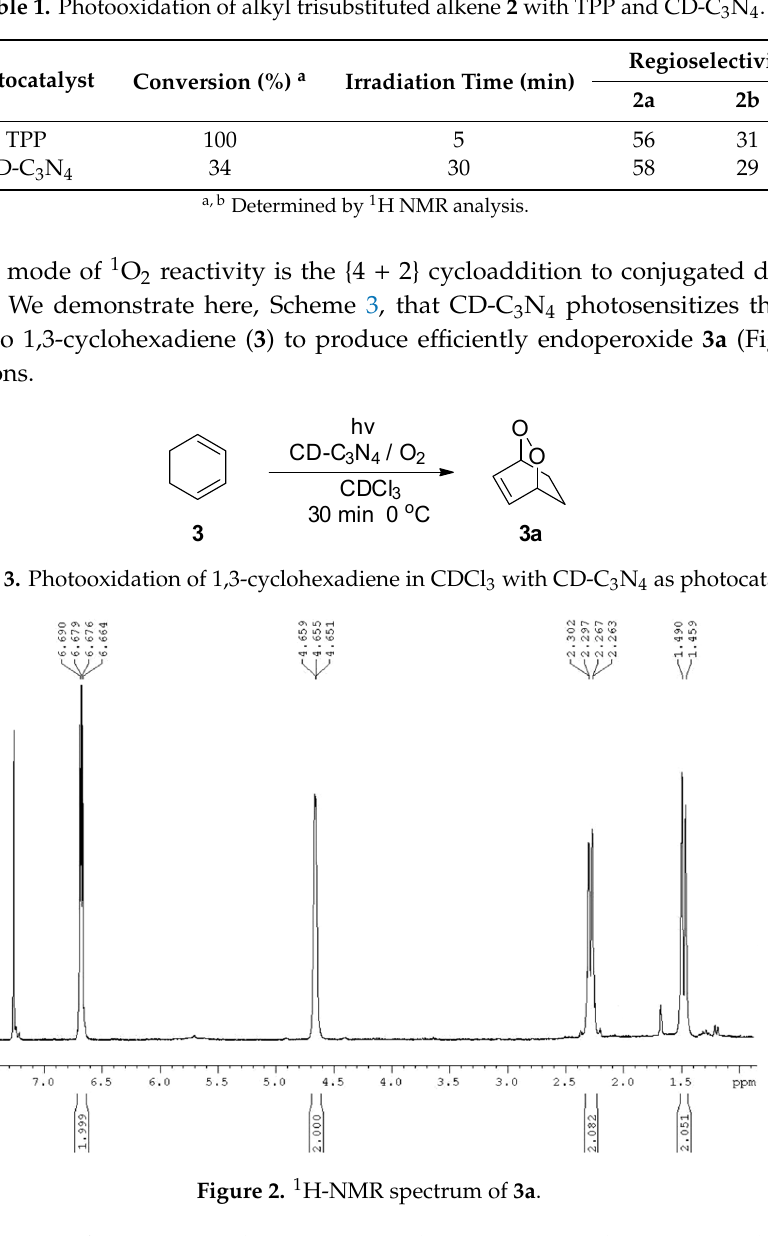
Table 1. Photooxidation of alkyl trisubstituted alkene 2 with TPP and CD-C 3 N 4 .